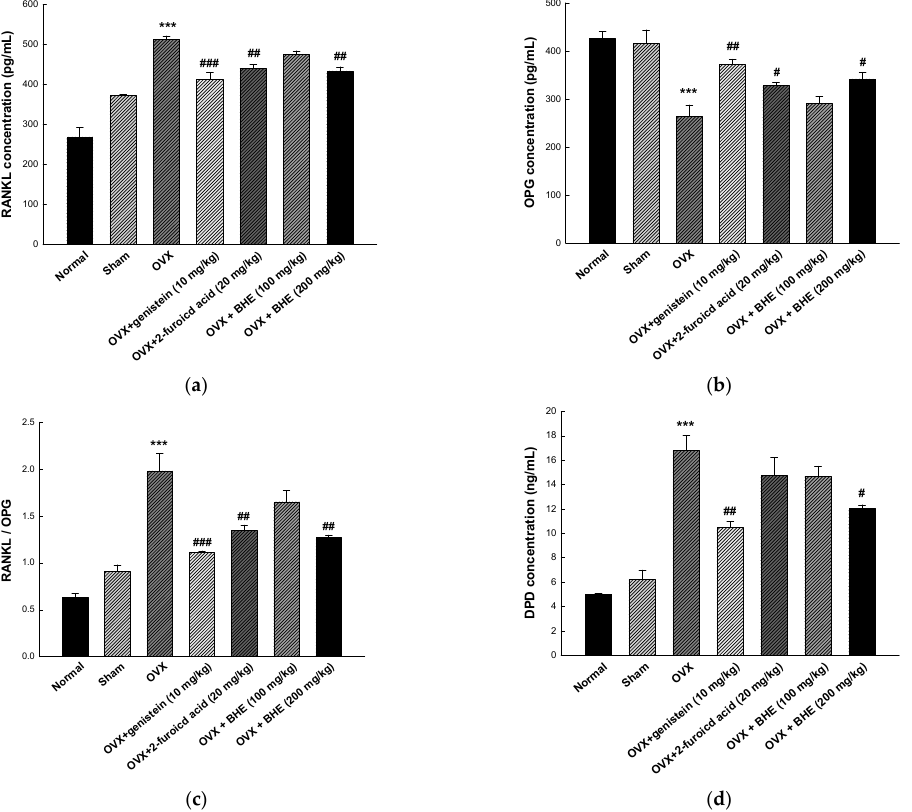
Figure 3. Effects of Benincasa hispida extracts (BHE, HR1901-W) on bone resorption markers in ovariectomy-induced osteoporosis mice. The concentration of ( a ) RANKL, ( b ) OPG, ( c ) RANKL/OPG ratio, and ( d ) DPD was determined using enzyme-linked immunosorbent assay (ELISA) kits. All values are expressed as the mean ± standard error of the mean (SEM). *** p < 0.001 vs. sham group; # p < 0.05, ## p < 0.01, and ### p < 0.001 vs. OVX group. RANKL, receptor activator of nuclear factor kappa-B ligand; OPG, osteoprotegerin; DPD, deoxypyridinoline; OVX,